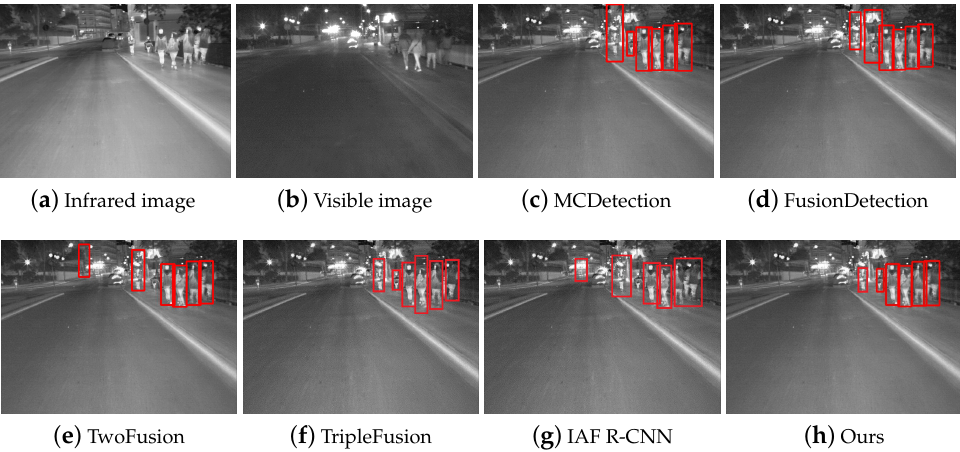
Figure 10. ( a – h ) The infrared and visible image detection results from six different detection methods. In order to better display the results, the detection results are shown on the fused